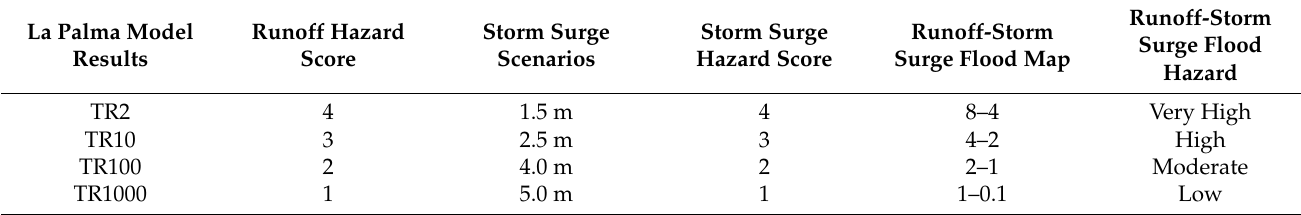
Table 4. Integration of the results for La Palma model and storm surge